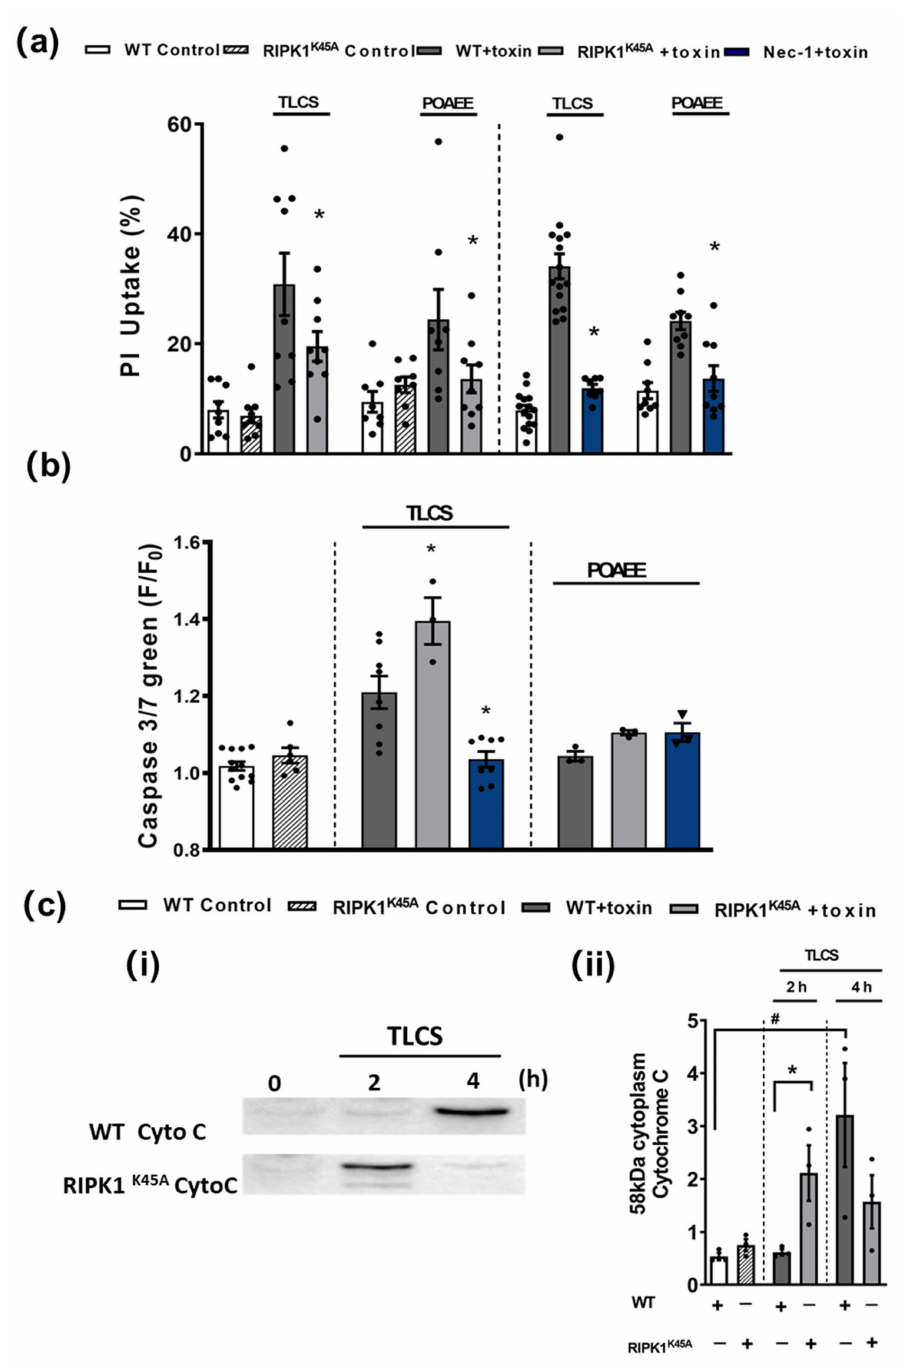
Figure 4. Effects of RIPK1K 45A and Nec-1 on TLCS- and POAEE-induced pancreatic acinar cell (PAC) death. ( a ) Bar graph showing the effects of RIPK1 K45A modification and Nec-1 (10 µ M) on TLCS (500 µ M)- and POAEE (100 µ M)-induced necrosis (propidium iodide (PI) uptake). Changes are normalized as the ratio of total cell number to necrotic cell number. ( b ) Bar graph showing the effects of RIPK1 K45A modification and Nec-1 (10 µ M) on TLCS (500 µ M) and POAEE (100 µ M) induced apoptosis (Caspase-3/7 green). The data are normalized as F/F 0 . ( c ) ( i ) Representative western blot images showing cytochrome C (58 KD) protein level in WT and RIPK1 K45A PACs at 0, 2 and 4 h with or without TLCS (500 µ M). ( ii ) Bar graph showing the quantification of cytoplasm cytochrome C levels in WT and RIPK1 K45A PACs at 0, 2 and 4 h with or without TLCS (500 µ M). Each dot represents a mouse. All data are expressed as the mean ± SEM ( n ≥ 3 mice/group). Significant differences are shown as * p < 0.05 and # p <